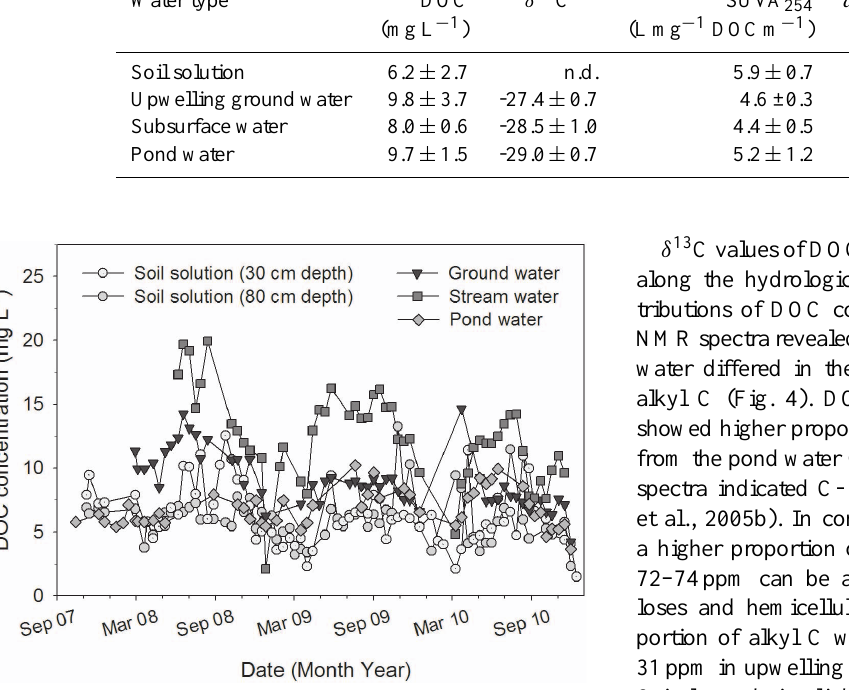
Fig. 3. Dynamics of DOC concentrations in soil solution at 30 and 80cm depth, ground water, stream water, and pond water ( n = 1). Results of Tukey’s post hoc test ( P < 0.05) for the period between February and May indicate that DOC concentrations in soil solu- tion at 30cm = soil solution at 80cm = pond water < stream wa- ter = upwelling ground